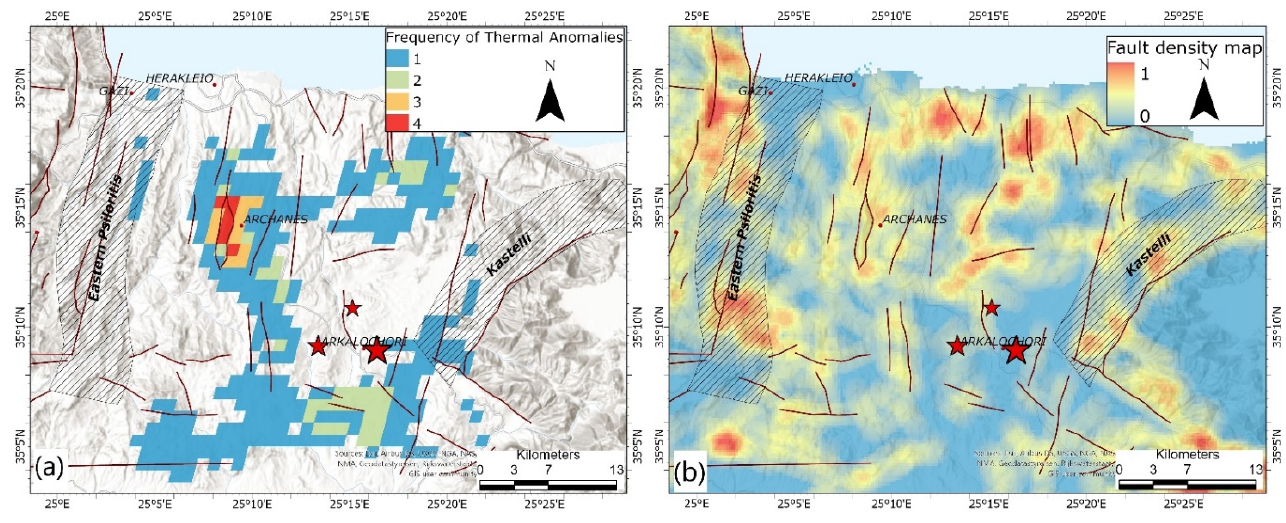
Figure 5. ( a ) Frequency map counting for each pixel the number of times it participated in one of the nine identified thermal anomalies during the pre-seismic period from July to September 2021; ( b ) normalized density faults map (see details in the text). The epicenters of the main event and of the two major aftershocks are shown with red stars.